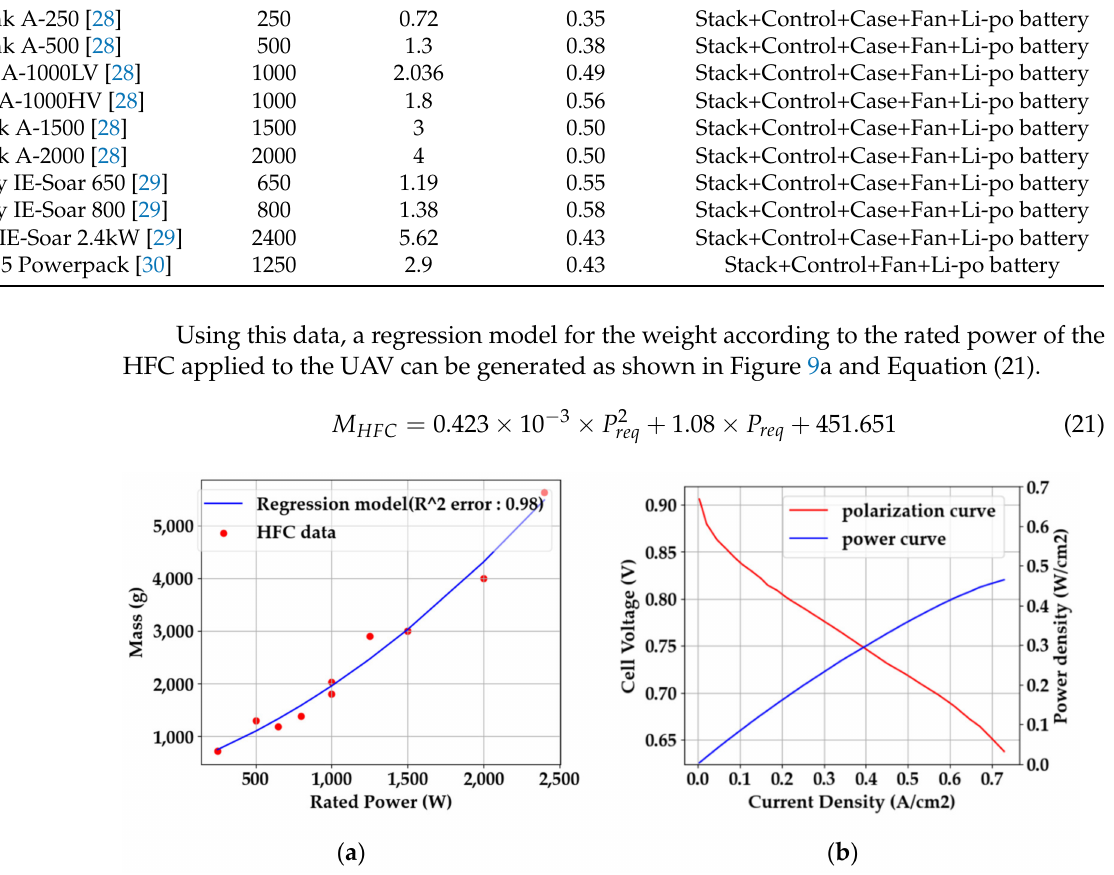
Figure 9. ( a ) Regression model for HFC sizing. The accuracy of the model was measured by the R -squared error, and the accuracy was high at 0.98. The unit of rated power is expressed in watts